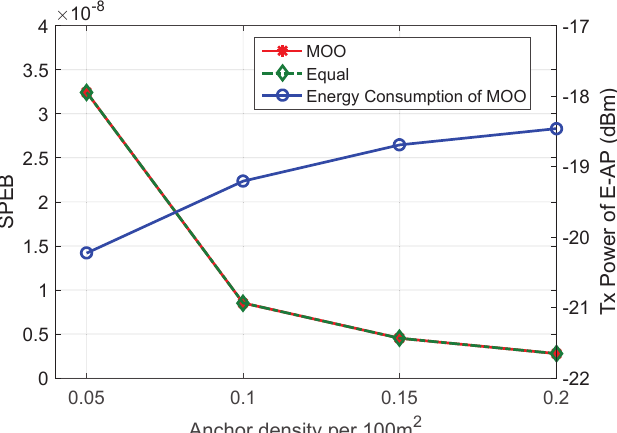
Figure 3. Optimal evaluation of anchor density.